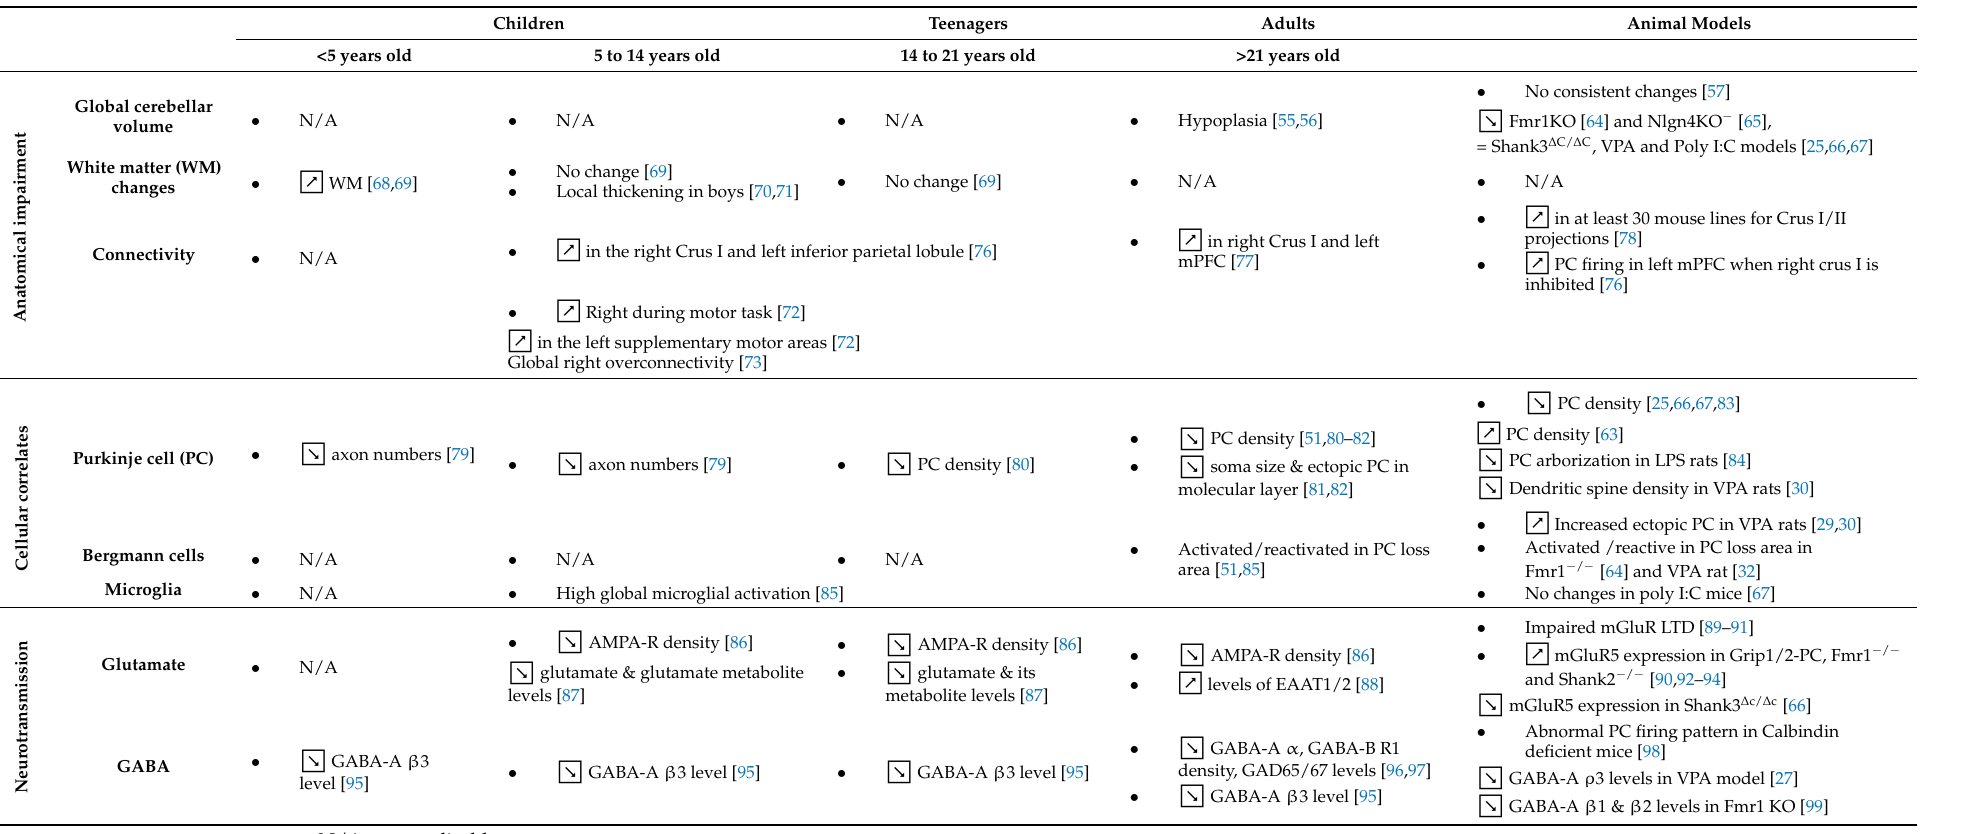
Table 1. Various outcomes in various animal models of valproic acid administration during development in relation with species, dose and age. This table reca- pitulates the different VPA models and their phenotypes. IP: Intraperitoneal injection, USV: Ultrasonic vocalizations, D1R and D2R: D1 dopamine receptor and D2 dopamine receptor, PC: Purkinje cells, MOR: Mu opioid receptor, PV: Parvalbumin interneurons, mPFC: median Prefrontal cortex, GABAP3: GABA receptor subunit p3.